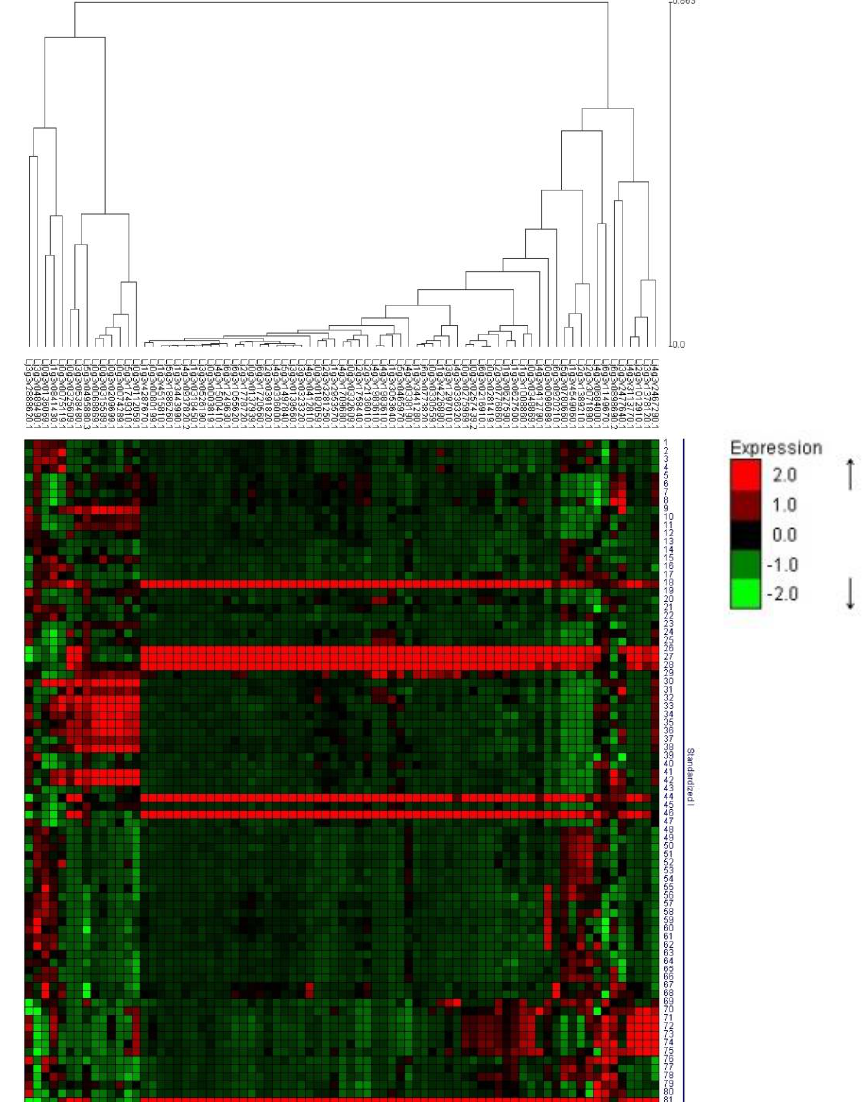
Figure 2. Hierarchical clustering of genes upregulated in Nod roots. The log2 of standardized levels of gene expression is shown for each one of the 81 conditions described in Table S1.